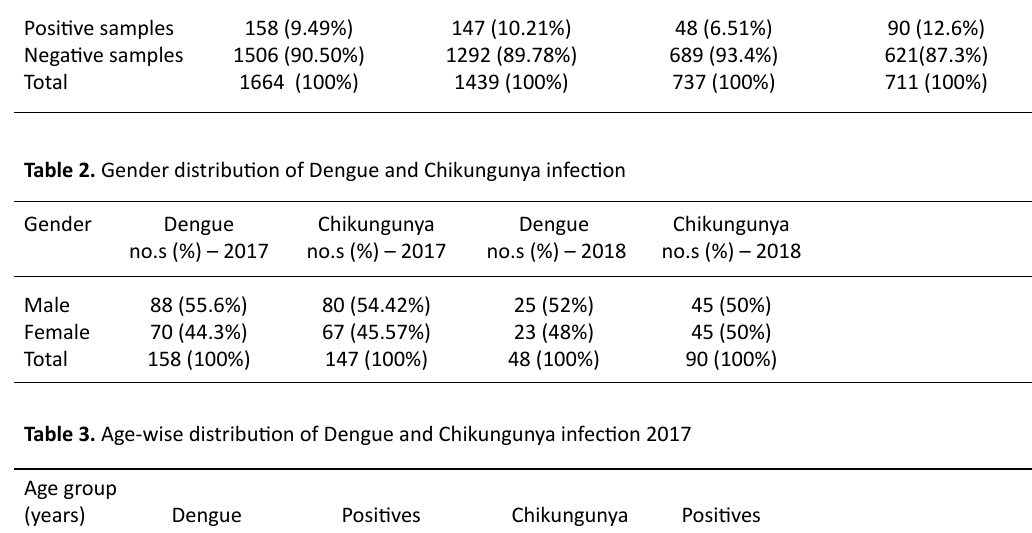
Positive samples